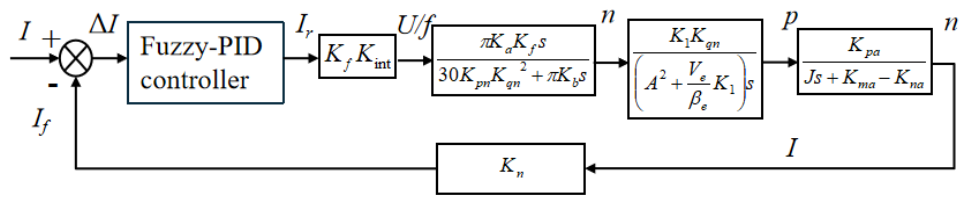
Figure 5. Transfer function block diagram of the new system for HVC.